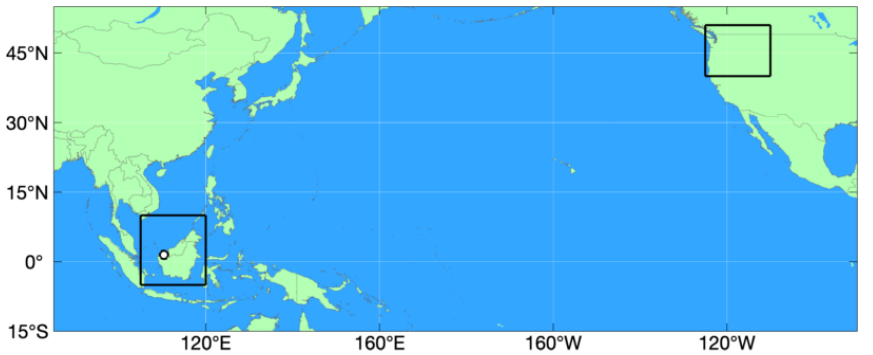
Figure 6. Map of the domains featured including the 15 ◦ × 15 ◦ Southeast Asian CATS domain. The MPLNET site at Kuching, Malaysia, is denoted by a